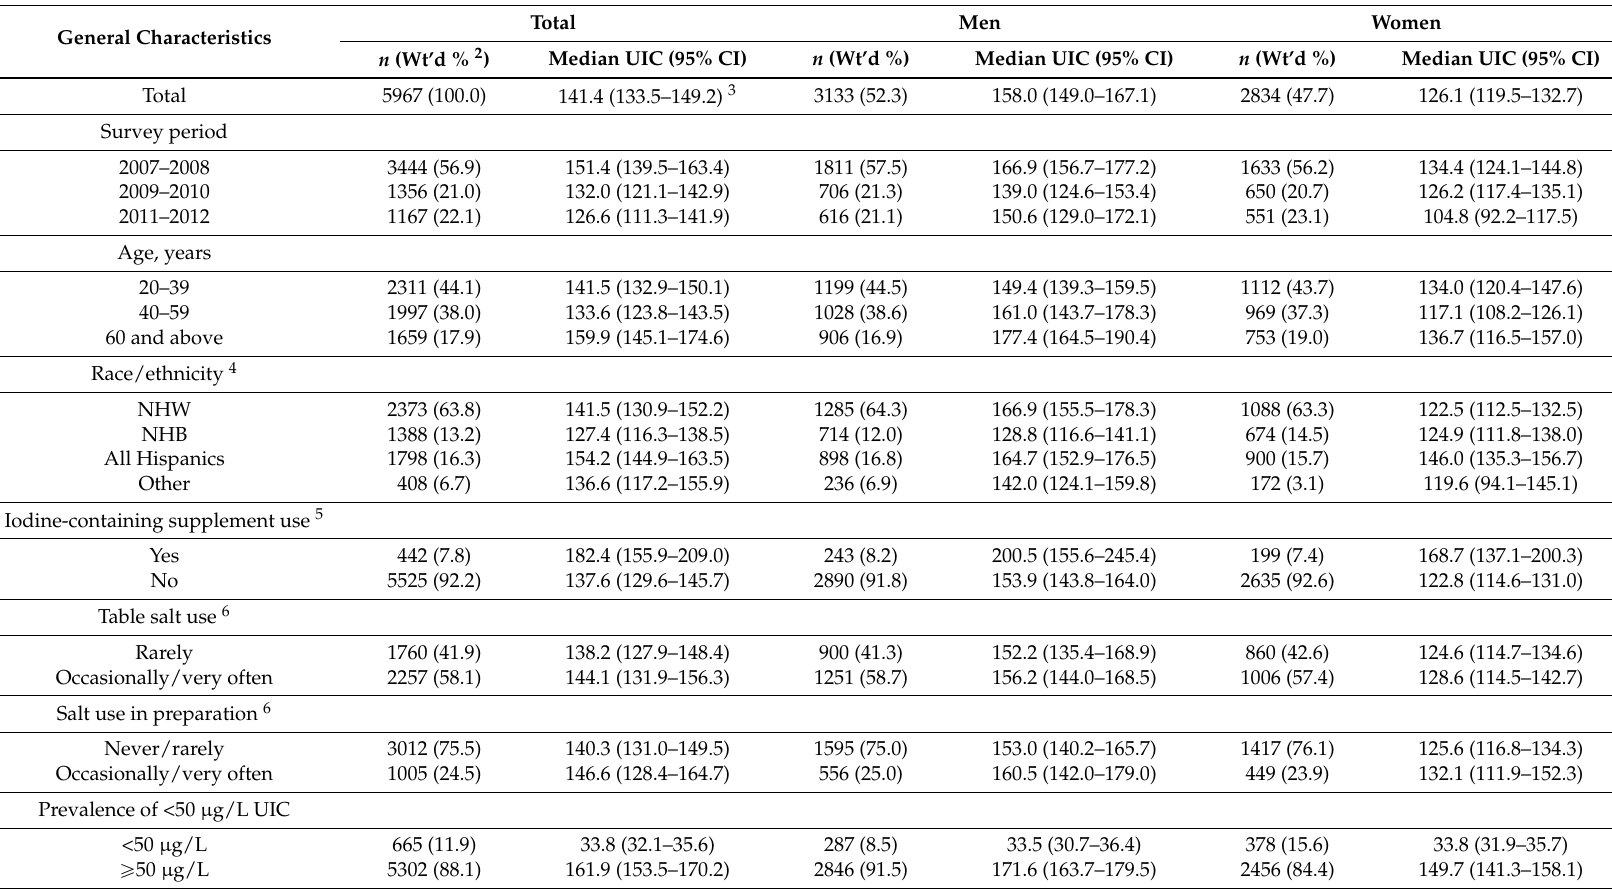
Table 1. Urinary iodine concentration by sociodemographic and lifestyle characteristics, NHANES 2007–2012 1